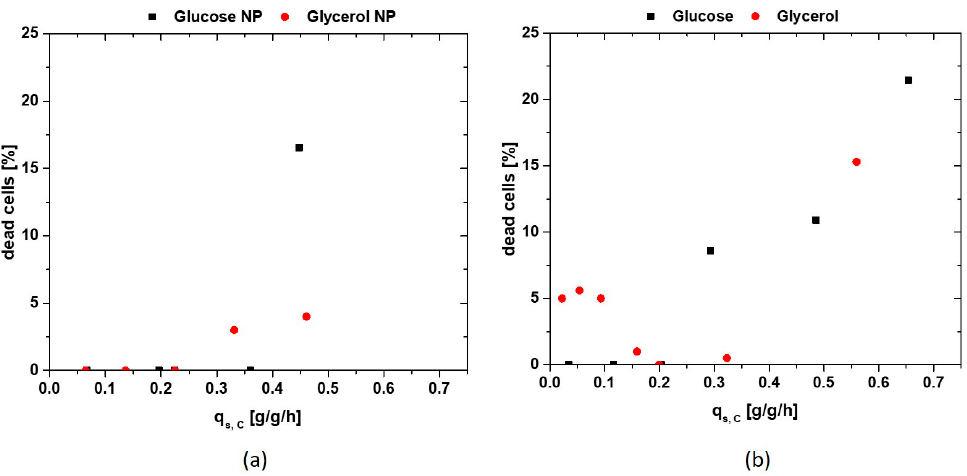
Figure 6. ( a ) Flow cytometry (FCM) analysis of NP strain 5 h after lactose pulse. As no protein data are received from these cultivations, the induction time was limited to 5 h; ( b ) FCM analysis of the product producing strain. Glycerol imposes stress at low feeding rates, while glucose shows increase in cell stress beginning at about 0.25 g/g/h.